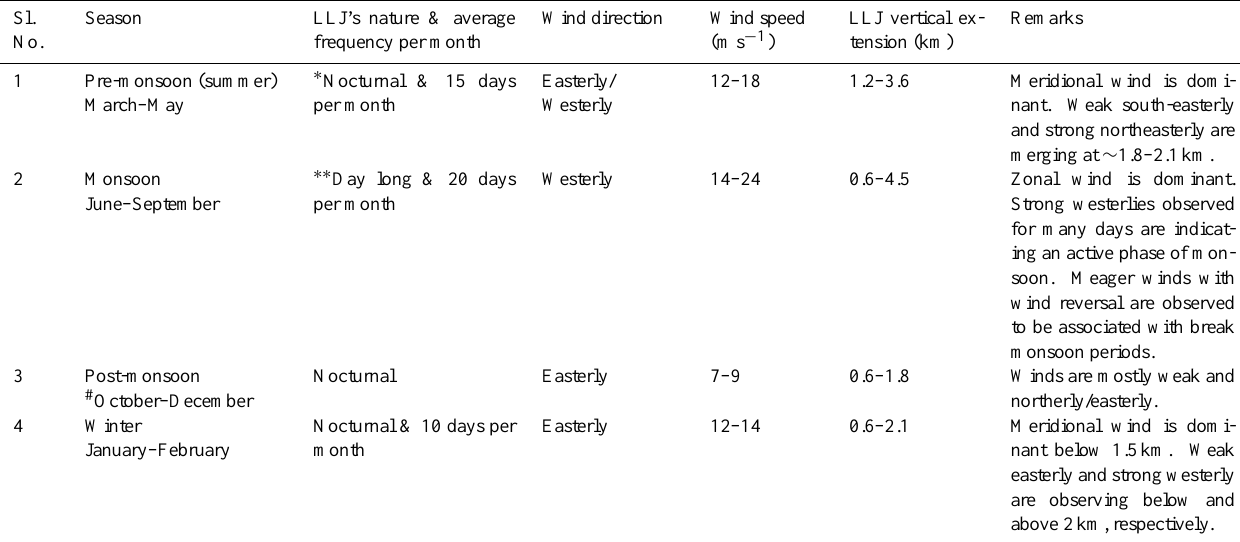
Table 1. Summary of LAWP observed low-level jet features over Gadanki during 1998–2000. Sl.